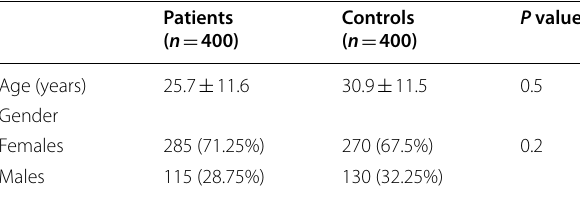
Table 1 Demographic characteristics of patients and controls